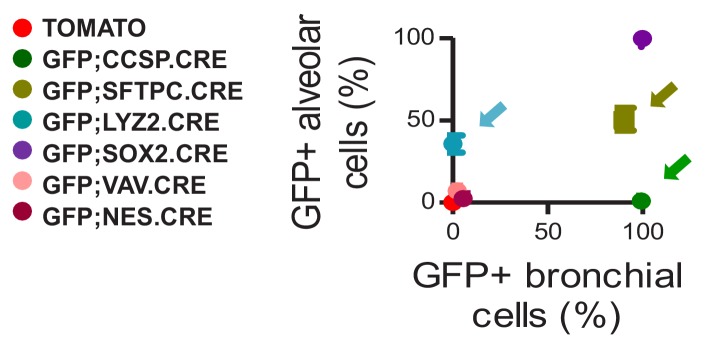
Genetic labeling of pulmonary lineages in seven lineage reporter strains on the C57BL/6 background: data summary.XY plot of GFP-labeled airway versus alveolar cells from n = 5 mice/mouse strain. Arrows denote the three lineage-reporter strains selected for further study including GFP;CCSP.CRE (green), GFP;LYZ2.CRE (blue), and GFP;SFTPC.CRE (olive) mice. Data are given as mean ± SD.10.7554/eLife.45571.008Figure 1—figure supplement 4—source data 1.Quantification of GFP+ alveolar and bronchial cells in our reporter mice.